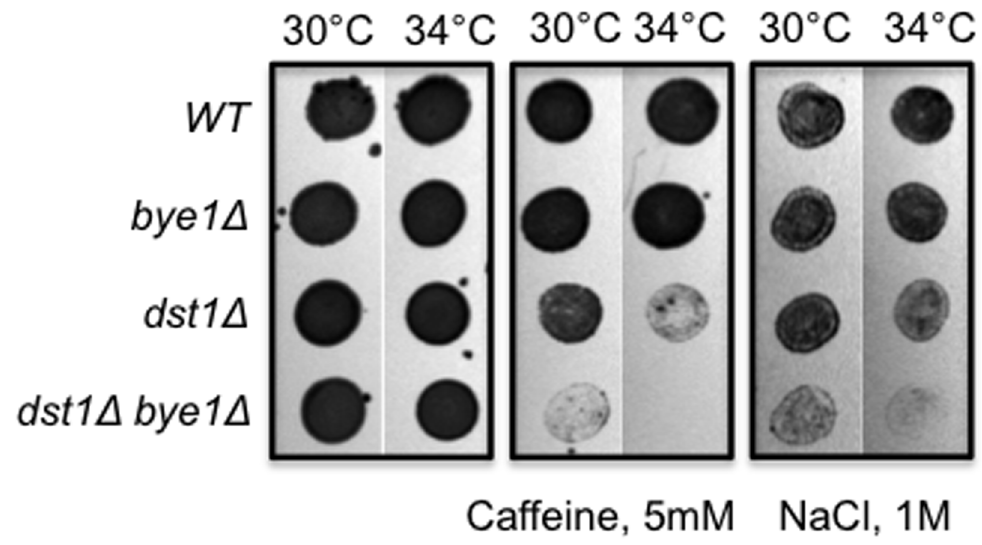
Figure 5. Bye1 and TFIIS exhibit a synthetic growth defect in response to high concentrations of NaCl and caffeine.